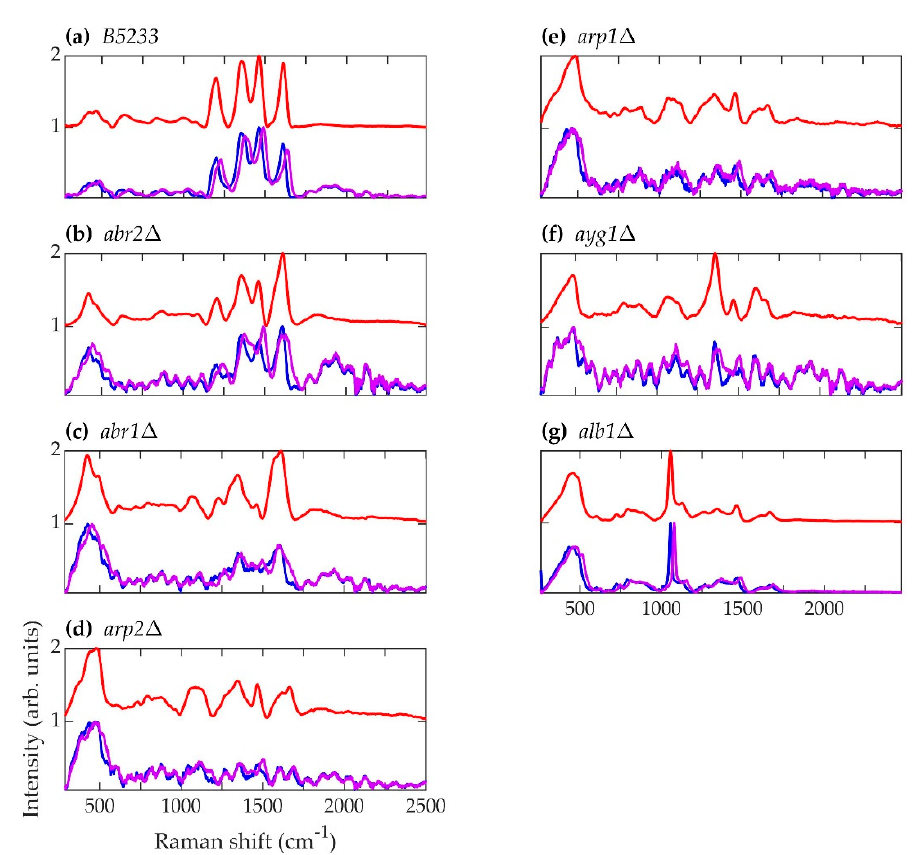
Figure 5. Spectra corresponding to A. fumigatus strains ( a ) B5233, ( b ) abr2 Δ , ( c ) abr1 Δ , ( d ) arp2 Δ , ( e ) arp1 Δ , ( f ) ayg1 Δ , and ( g ) alb1 Δ . Blue (~784.2nm laser excitation) and purple (~785.8nm laser excitation) curves are the average normalized background-subtracted raw spectra, while the red curves are average retrieved pure Raman spectra.